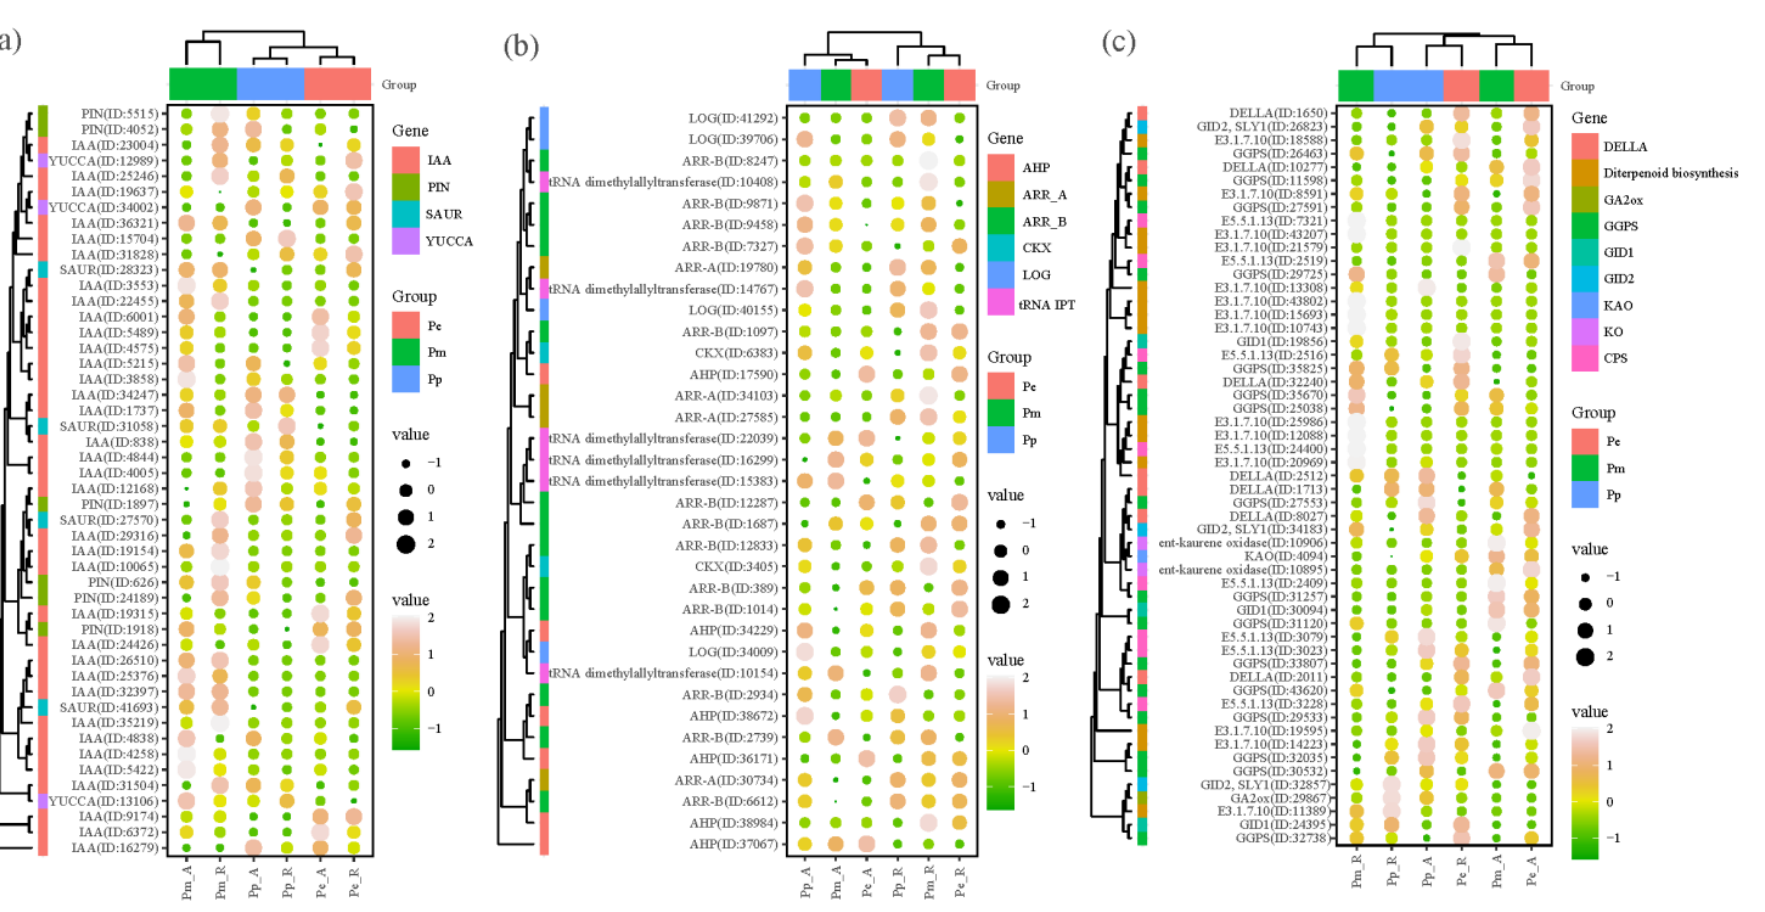
Figure 3. The DEGs involved in the synthesis and response of IAA, CK, GA. ( a ) The DEGs involved in the synthesis and response of IAA; ( b ) the DEGs involved in the synthesis and response of CK; ( c ) the DEGs involved in the synthesis and response of GA. Note: SAUR , small auxin upregulated RNA; ARR_A , two-component response regulator ARR-A family; ARR_B , two-component response regulator ARR-B family; AHP , histidine-containing phosphotransfer peotein; CKX , cytokinin dehydrogenase; LOG, LONELY GUY; tRNA IPT, tRNA dimethylallyltransferase; GA2ox , GA 2-oxidase; GGPS , geranylgeranyl pyrophosphate synthase; KAO , ent-kaurenoic acid oxidase; KO , ent-kaurene oxidase; CPS, ent-copalyl diphosphate synthase.